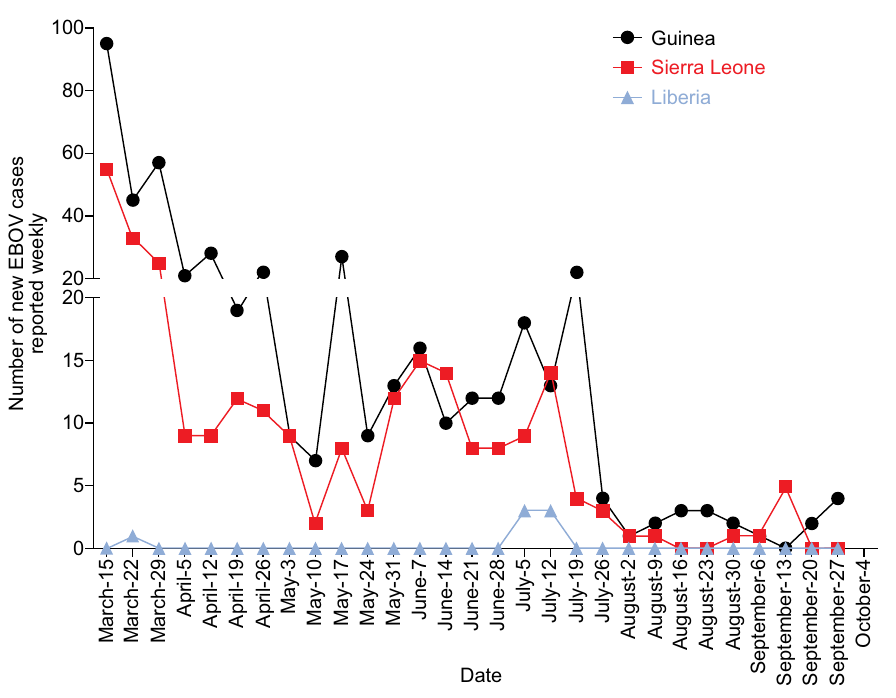
Figure 1. Numbers of new EBOV infections per week in Guinea, Sierra Leone and Liberia. Numbers are reported by the World Health Organization, and the dates are from March 15th to September 27th,